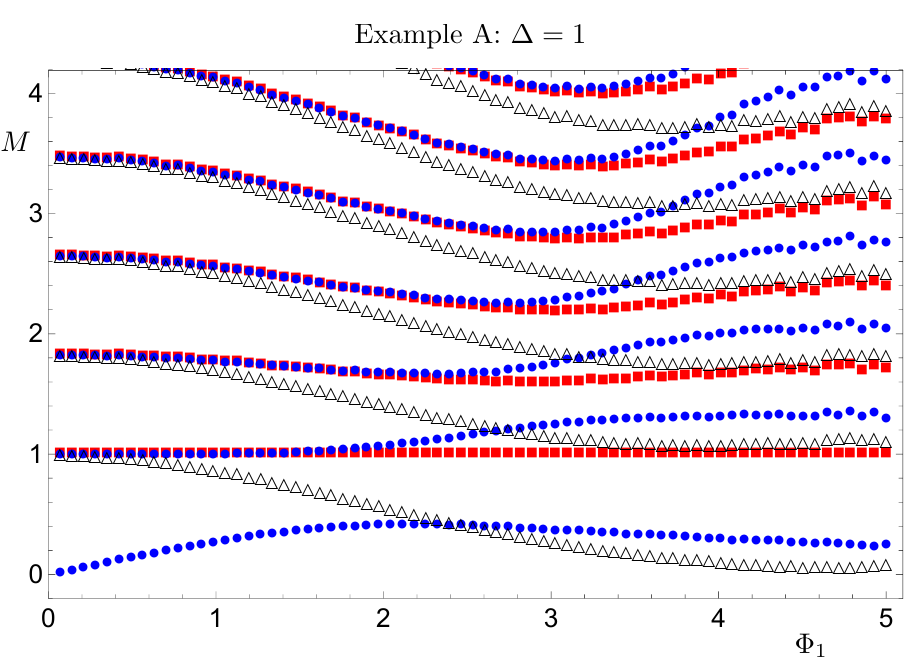
p Figure 1 . Masses M = (cid:0) q 2 of (cid:13)uctuations in the GW system, for (cid:1) = 1, r 1 = 0, r 2 = 6, and a 0 = 0, as a function of the integration constant (cid:8) 1 . All masses are expressed in units of the mass of the lightest tensor mode. The (red) squares represent the tensor modes, the (blue) disks are the scalar modes, computed with the complete, gauge-invariant variables. The (black) triangles are the scalar modes computed by making use of the probe